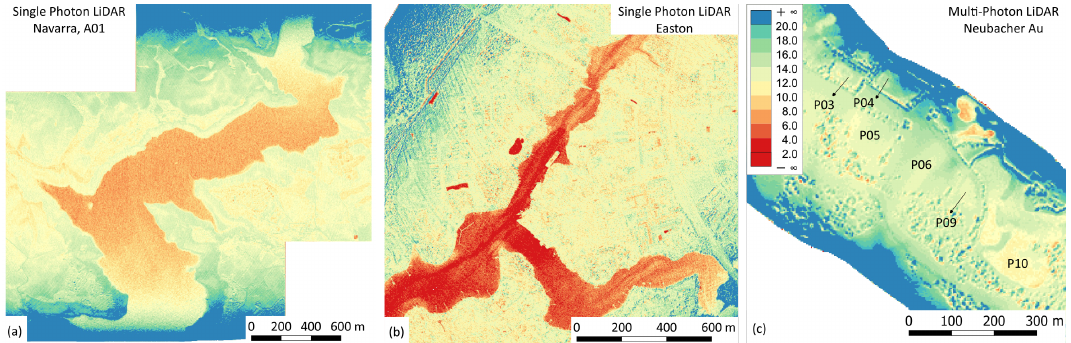
Figure 7. Color-coded point density maps [points/m 2 ] for Single Photon LiDAR ( a , b ) and Multi-Photon LiDAR ( c